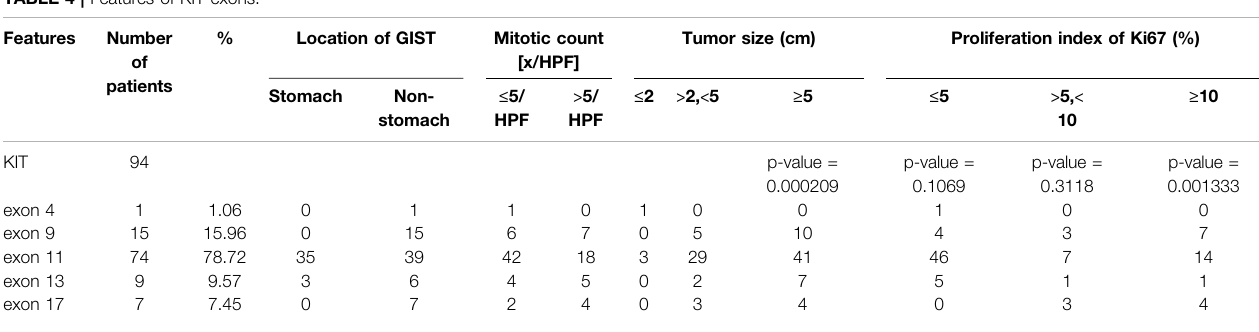
TABLE 4 | Features of KIT